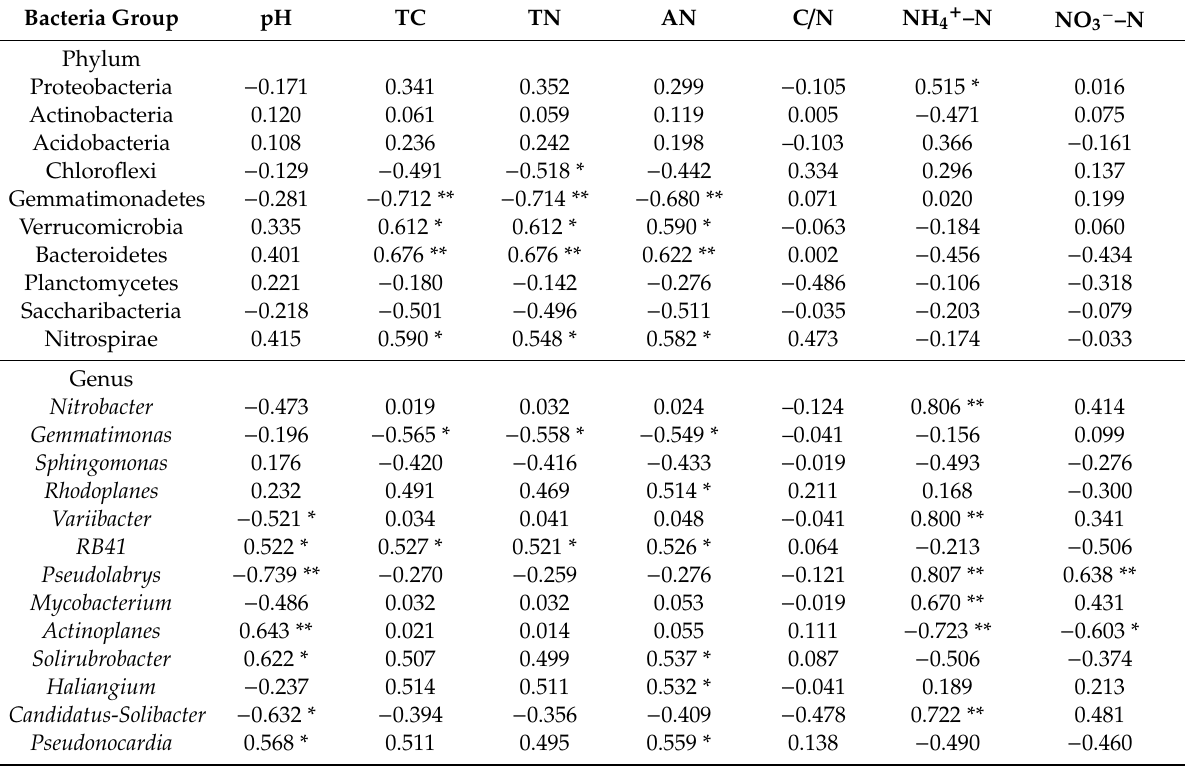
Table 5. Correlation coe ffi cients between dominant bacteria groups and available edaphic